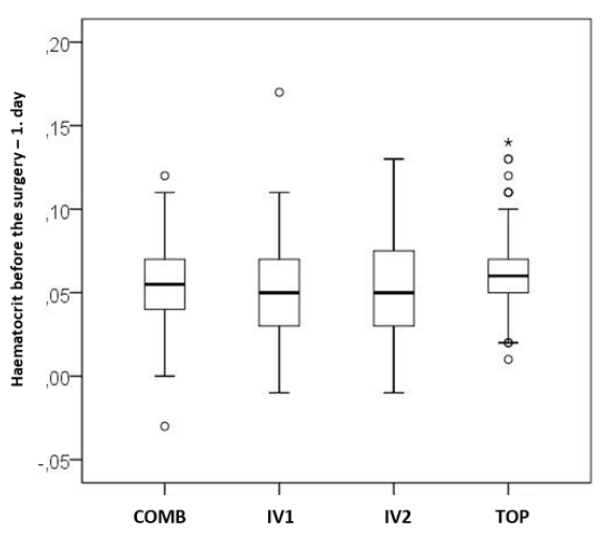
Fig. 5. Graphical representation of the difference between pre- operative haematocrit and post-operative day 1.